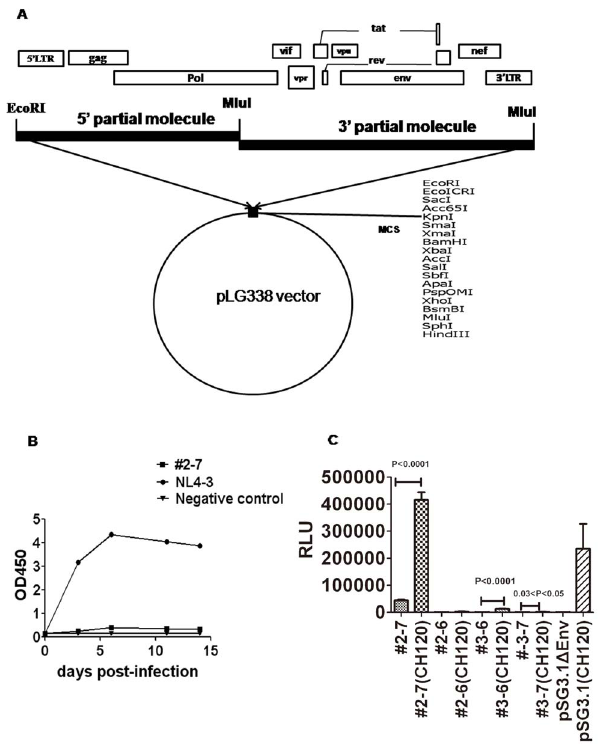
Figure 1. Generation of full-length molecular clones. (A) Diagram of the full-length molecular cloning method. (B) Replication capability of full-length clone pXJDC2-7 on human PBMCs. pNL4-3 derived virus was used as the positive control. Viral replication was monitored by quantifying OD value in the culture medium at defined time points using a commercial p24 antigen-capture ELISA. (C) Viral infectivity produced from co-transfection of clade BC envelope expression plasmid CH120.6 and either the full-length molecular clone. pSG3 D Env HIV-1 backbone plasmid was used as positive control. The data are shown as the mean relative light unit (RLU) with standard deviation from four independent experiments.